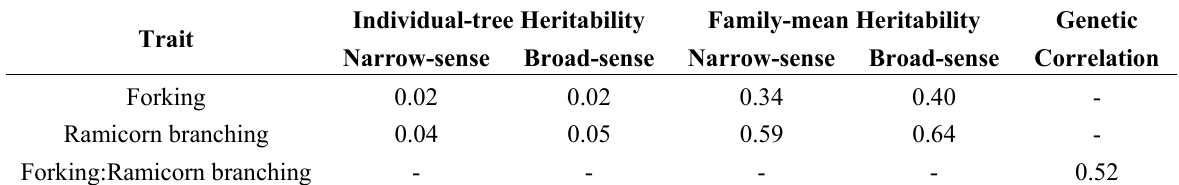
Table 1. Across-site heritabilities and genetic correlation for incidences of forking and ramicorn branching, obtained at age-7 from second cycle tests in Douglas-fir in the Pacific Northwest of the United States; estimates for forking and ramicorn branching based on 70 sites and 174,738 trees, and 73 sites and 187,239 trees respectively (unpublished Northwest Tree Improvement Cooperative data). Individual-tree Heritability Family-mean Heritability Genetic Trait CorrelationNarrow-sense Broad-sense Narrow-sense Broad-sense Forking 0.02 0.02 0.34 0.40 - Ramicorn branching